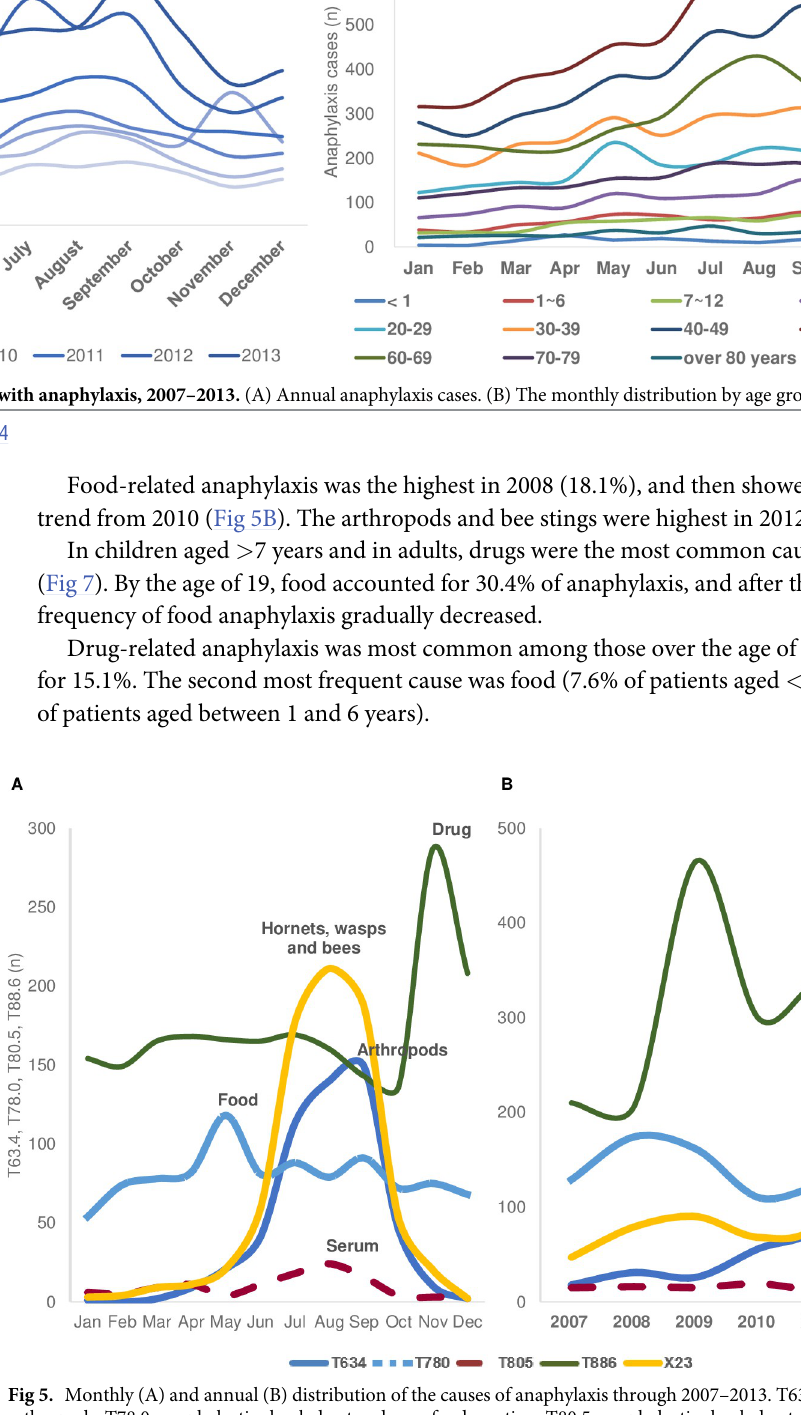
Fig 5. Monthly (A) and annual (B) distribution of the causes of anaphylaxis through 2007–2013. T63.4, venom of other arthropods; T78.0, anaphylactic shock due to adverse food reaction; T80.5, anaphylactic shock due to serum; T88.6, anaphylactic shock due to the adverse effect of an appropriate drug or medication properly administered; T78.2, anaphylactic shock, unspecified; X23, contact with hornets, wasps, and bees.